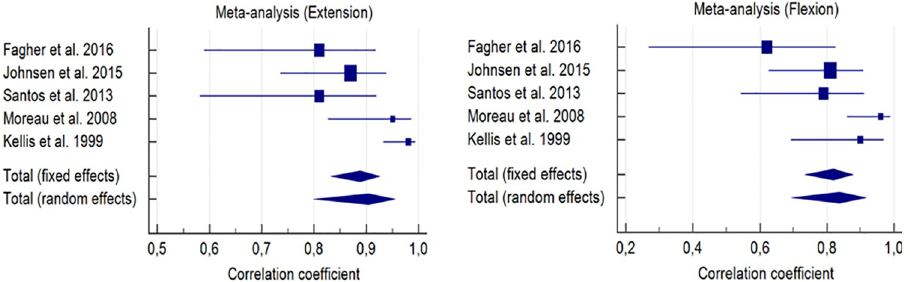
Fig 2. Reliability forest plot between evaluators (Bayes estimation) for each study, (random-effects model), with a 95% confidence interval for each reliability coefficient. Extension of knee (first figure) and knee flexion